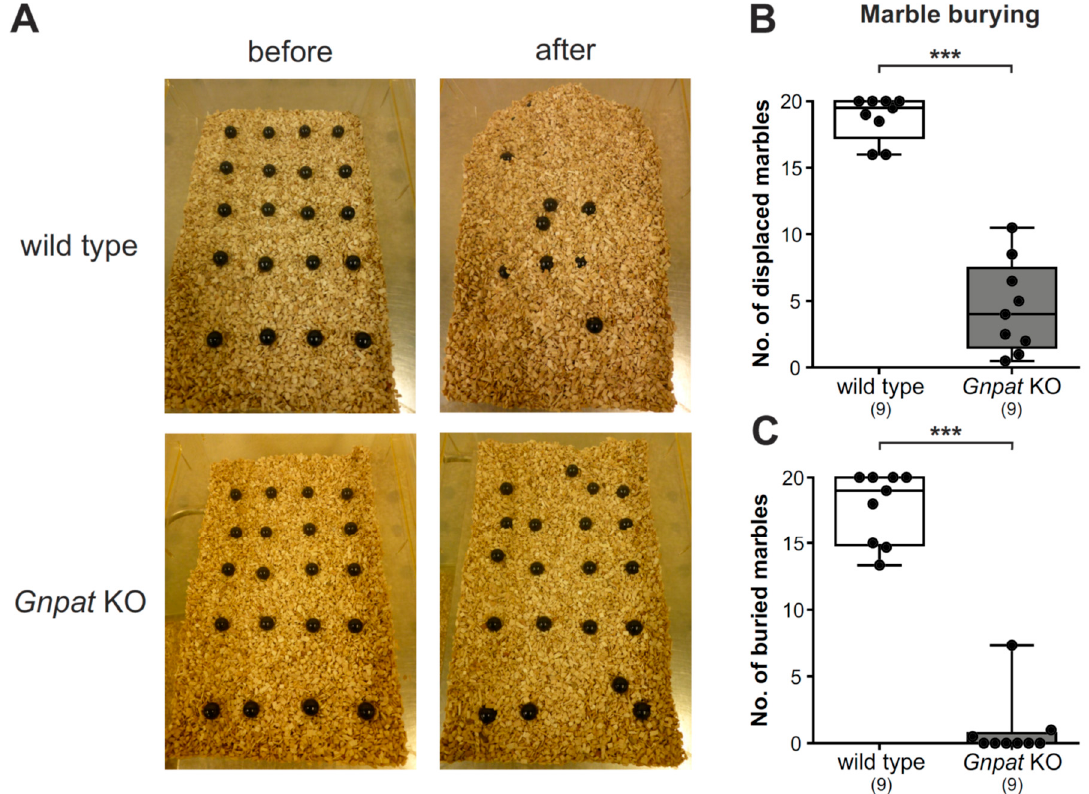
Figure 2. Striking alterations in the marble burying assay in ether lipid-deficient mice: Marble burying behavior was examined in WT and Gnpat KO mice, and representative pictures before and after 30 min trial time are shown ( A ). The number of marbles displaced ( B ) and buried ( C ) were quantified. Data are shown as box plots together with individual data points, and whiskers indicate minimal and maximal values. The number of tested animals is given in brackets. Statistical analysis was performed using the Mann–Whitney U test. *** p < 0.001 .